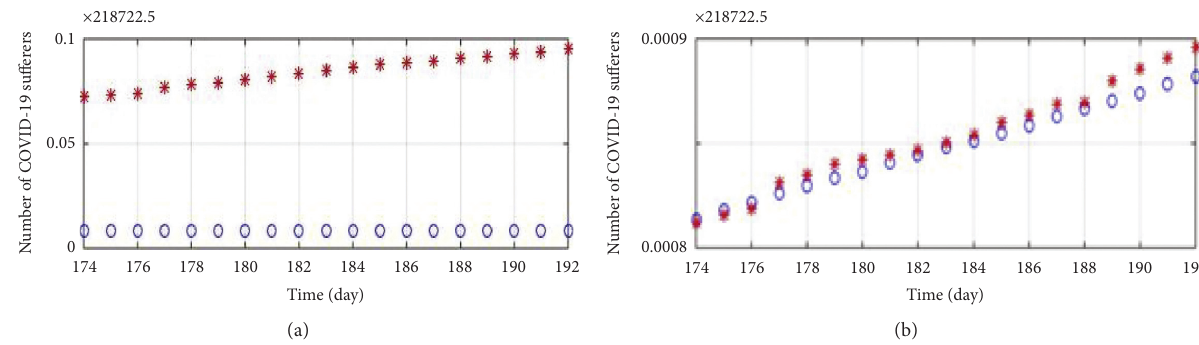
Figure 4: Comparison between the number of COVID-19 sufferers from the actual data and the number of COVID-19 sufferers predicted by the Backpropagation algorithm for testing data. (a) Backpropagation neural network with the gradient descent method. (b) Back- propagation neural network with the Fletcher–Reeves